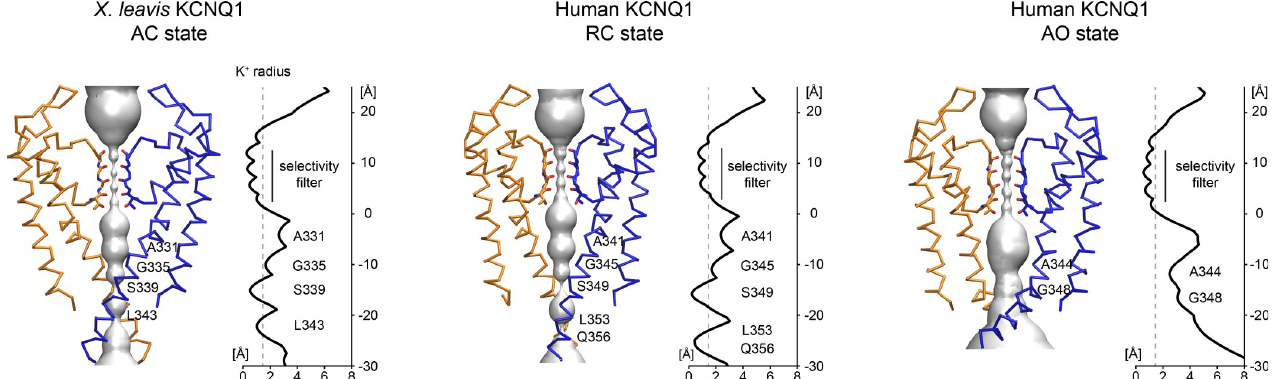
Fig 2. Pore conformation in the X . leavis KCNQ1 structure and human KCNQ1 RC and AO homology models. Left: surface representation of the channel pore. Subunits at the front and back are excluded for clarity. The selectivity filter is displayed as sticks. Amino acid residues facing the pore are labeled. Right: pore radius calculated from the X . leavis KCNQ1 structure and the human KCNQ1 homology models. The approximate radius of a K + ion is indicated by a gray dashed line.